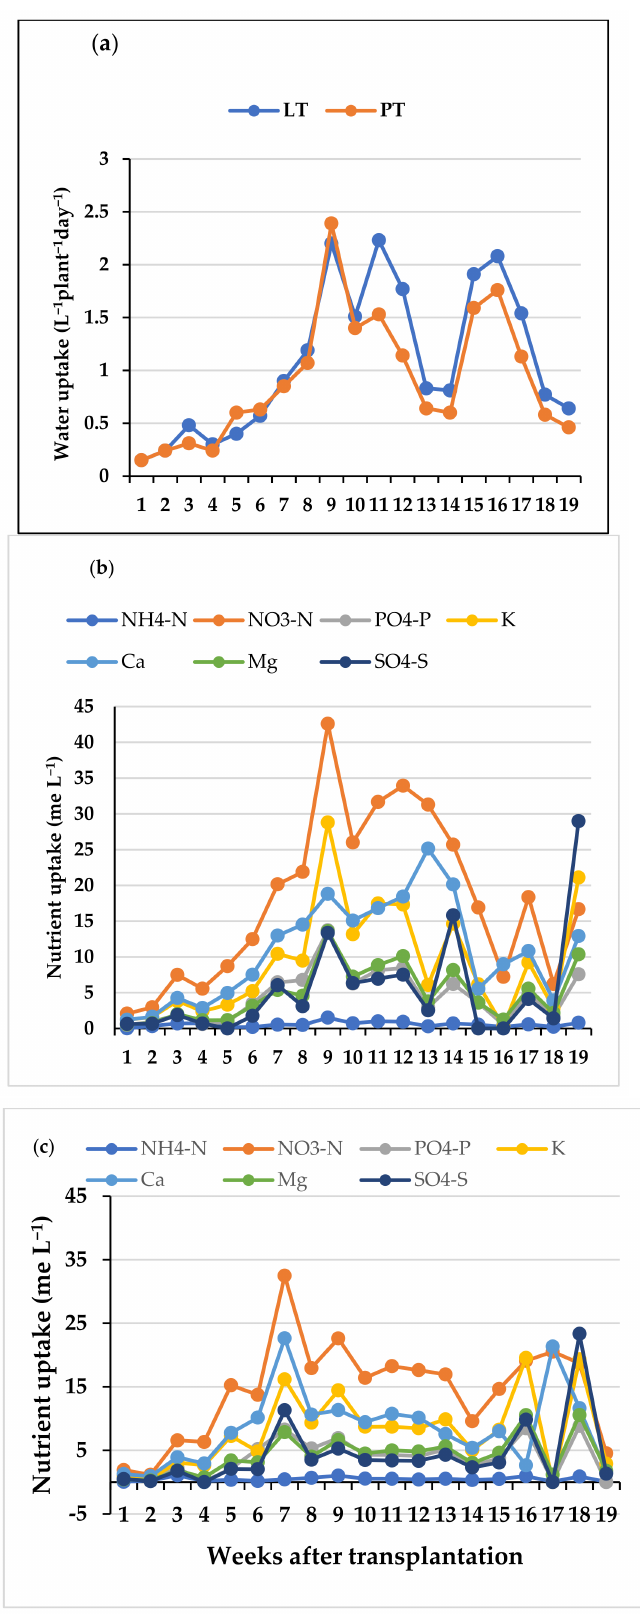
Figure 7. ( a ) Water uptake in the two treatments, ( b ) nutrient uptake in the LT treatment, ( c ) nutrient uptake in the PT